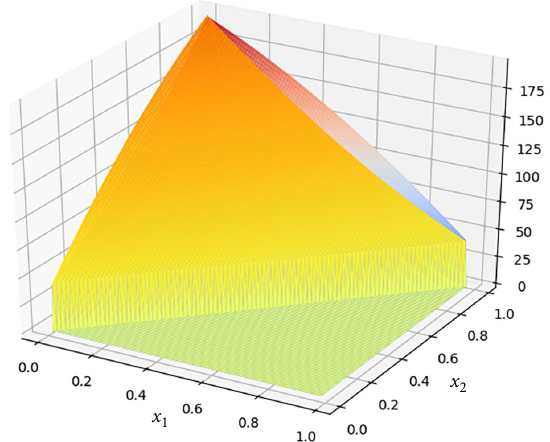
Figure 3. The evolution process of the optimal price of building developers 1 and 2 when h = 0.8 ( x 1 and x 2 is the consumer’s preference on prefabricated building product 1 and traditional cast-in-situ building product 2,